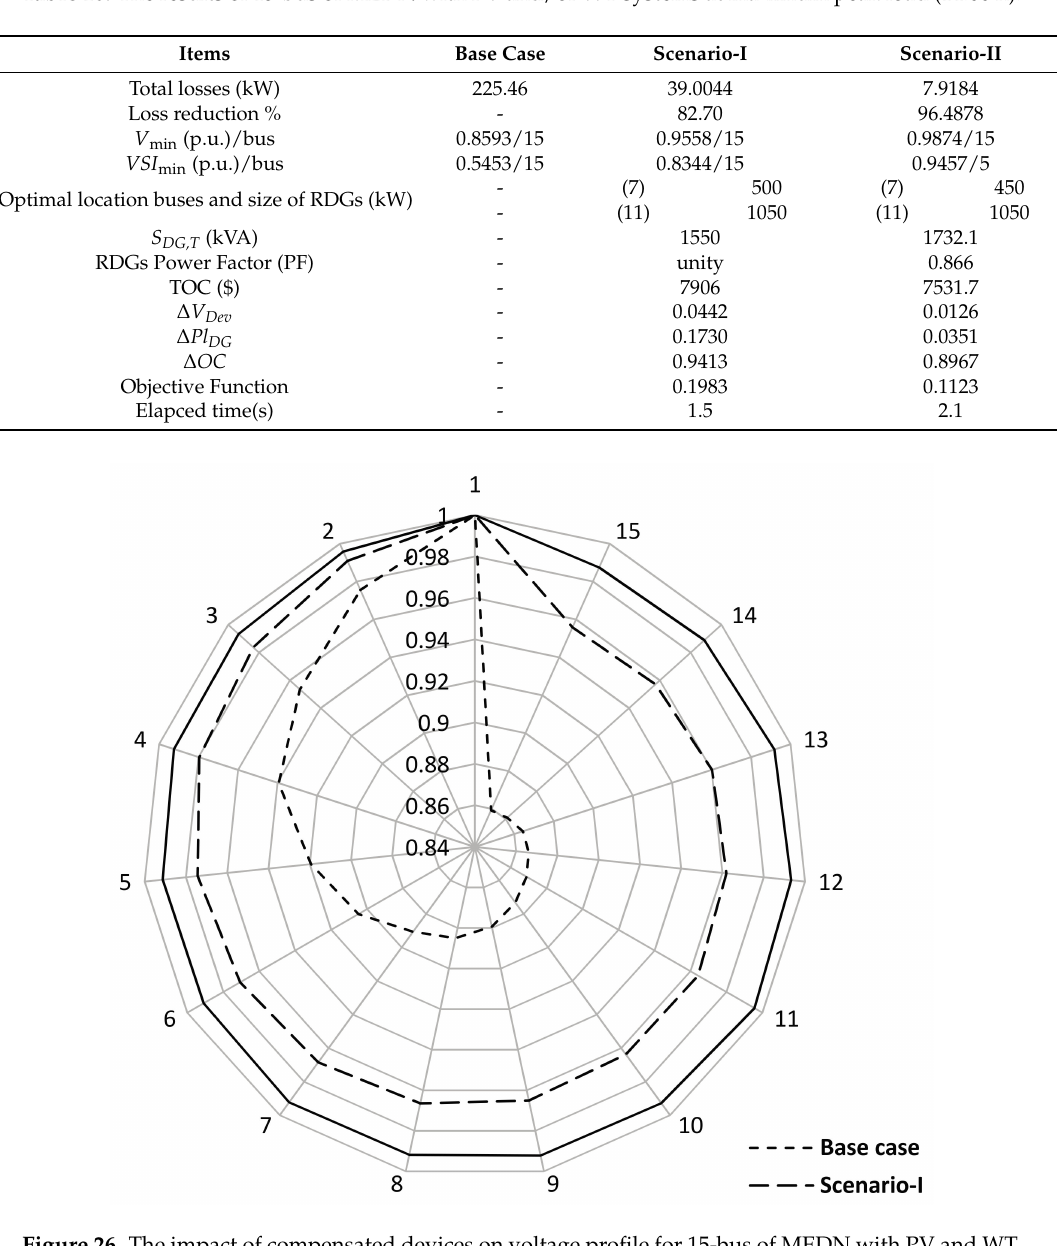
Figure 26. The impact of compensated devices on voltage profile for 15-bus of MEDN with PV and